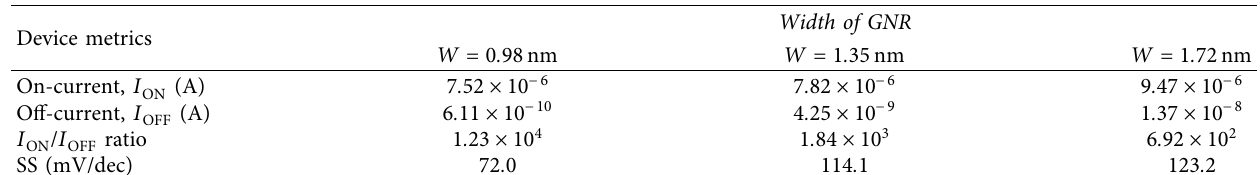
Figure 4: I–V characteristics of SB-GNR-FETs with GNR width scaling, simulated at V Table 3: Device performance of SB-GNR-FETs with GNR width